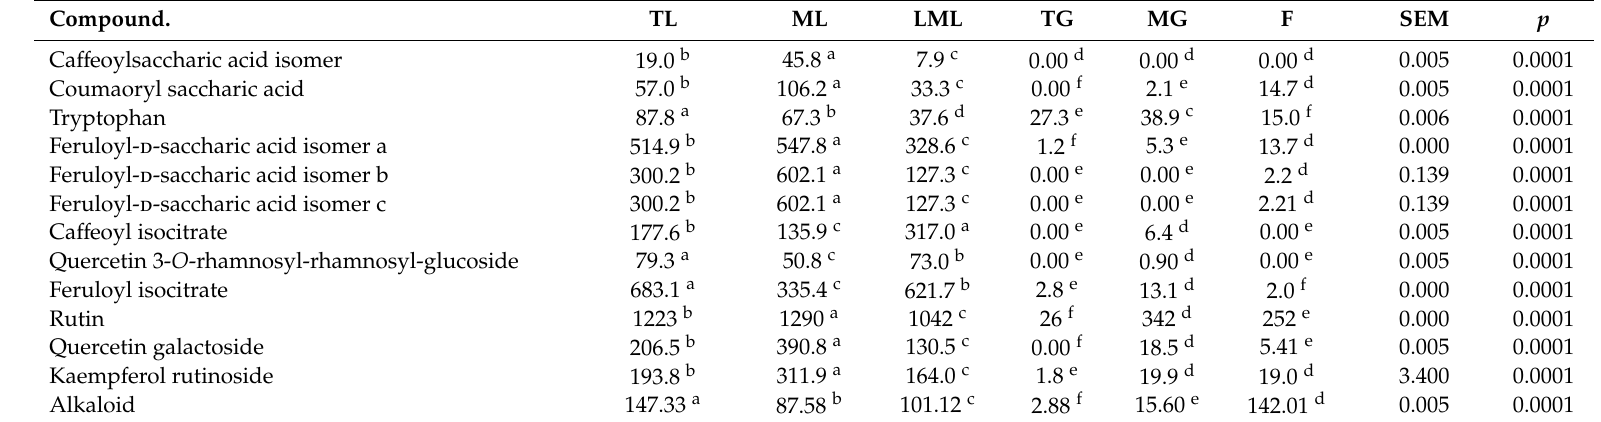
Table 2. Quantified individual phenolic compounds in amaranth plant parts (mg / kg).